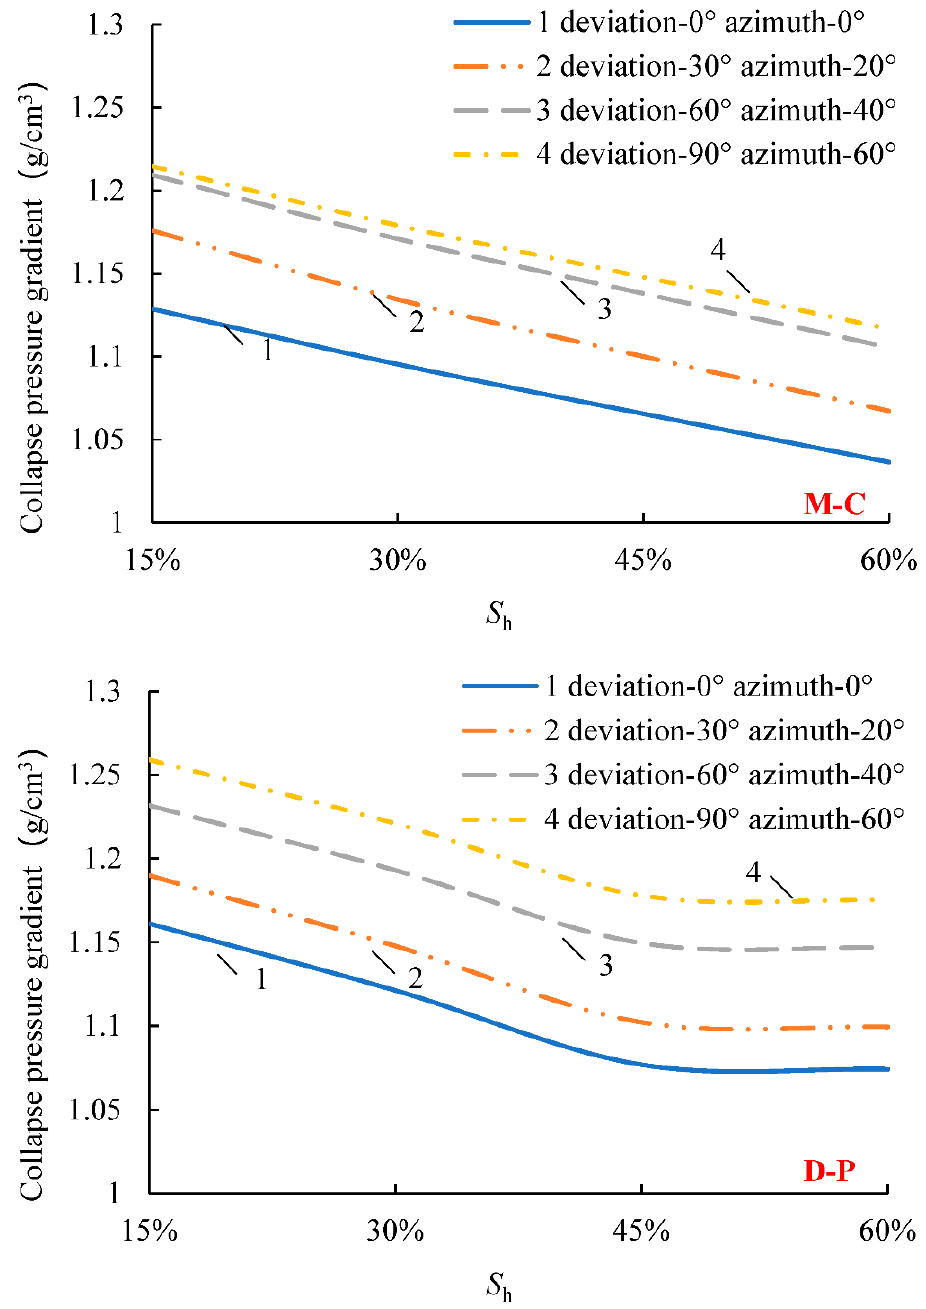
Figure 7. Hydrate saturation and collapse pressure gradient relationship curves by the two crite-